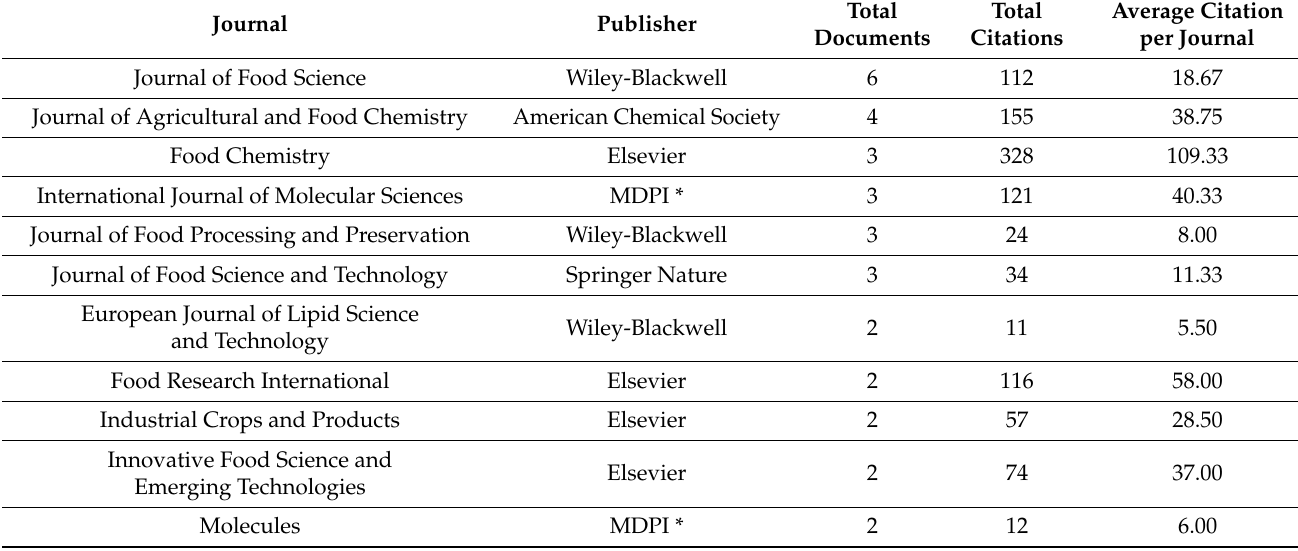
Table 1. Most productive journals in the enrichment of VOs with natural antioxidants.